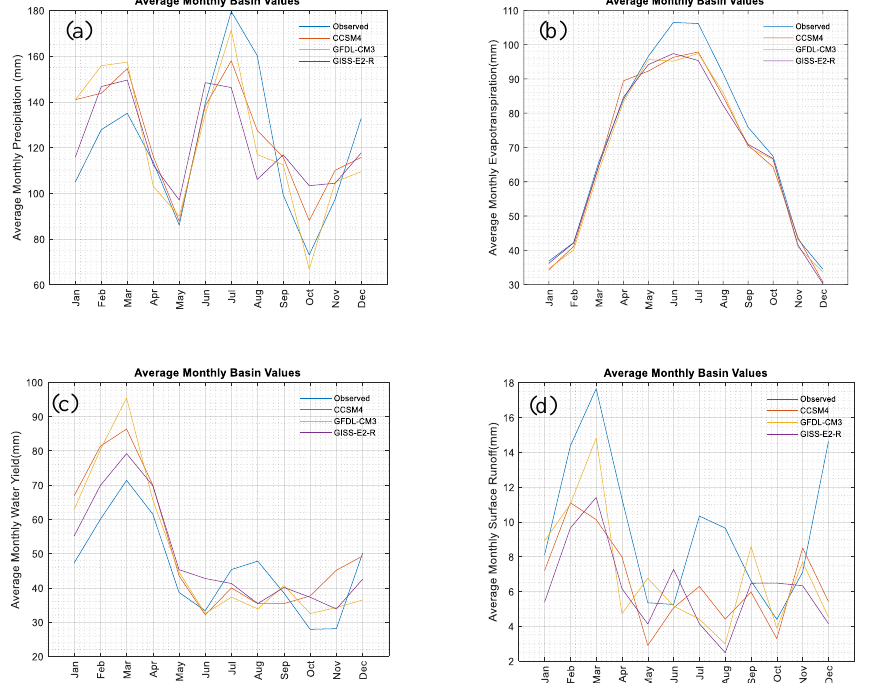
Figure 5. Comparing monthly average of precipitation, ET, water yield, and surface runoff for models and observed data. Subgraph ( a ) compares monthly observed rainfall to the models result. Subgraph ( b ) compares monthly observed ET to the models result. Subgraph ( c ) compares monthly observed water yield to the models result. Subgraph ( d ) compares monthly observed surface runoff to the models result.